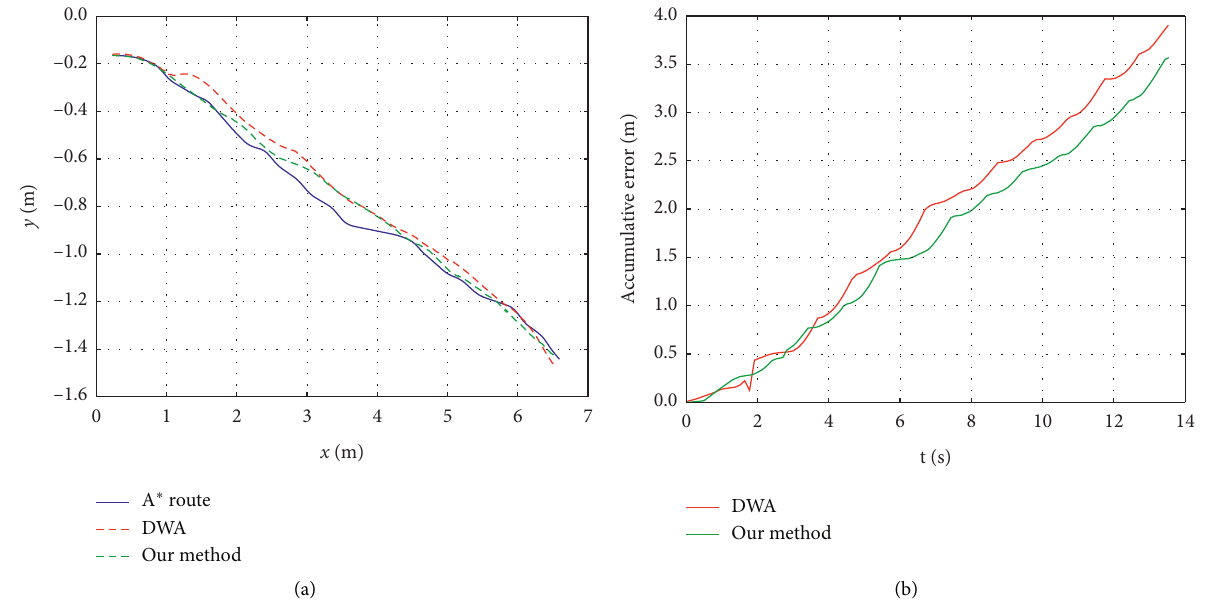
Figure 16: Experiment results. (a) Running trajectory. (b) Cumulative